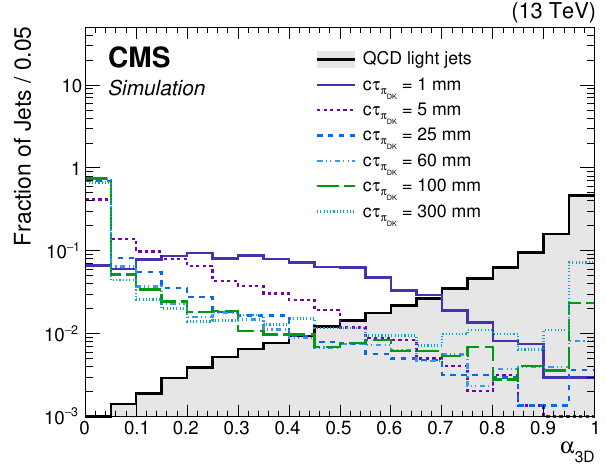
Figure 3 . Distributions of (cid:11) 3D for background (black) and for signals with a mediator mass of 1 TeV and a dark pion mass of 5 GeV for dark pion proper decay lengths ranging from 1 to 300